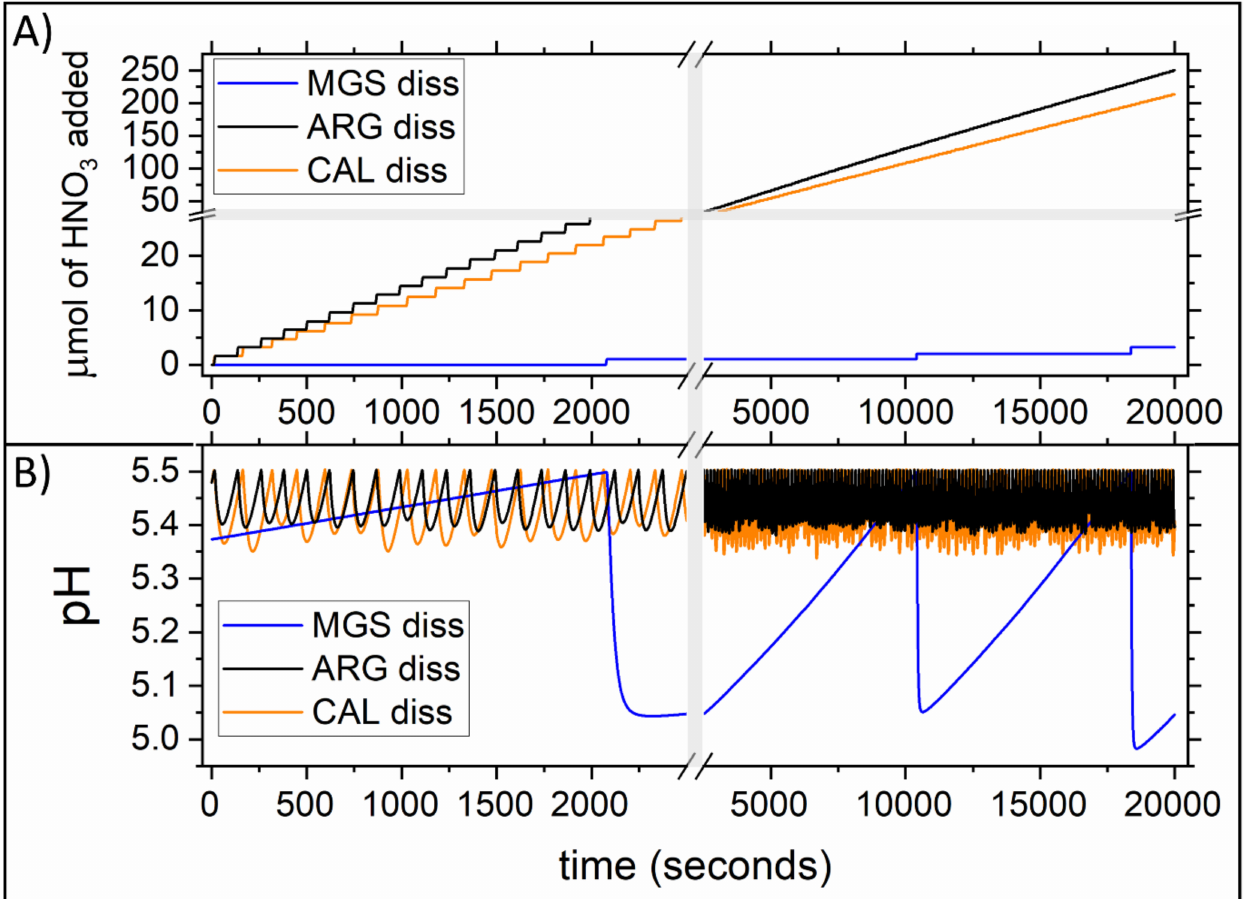
Figure 2. ( A ) µ mol of HNO 3 added during the dissolution of magnesite (MGS), aragonite (ARG) and calcite (CAL). ( B ) pH cycles during carbonate dissolution. The grey areas are used to highlight the presence of breaks in the